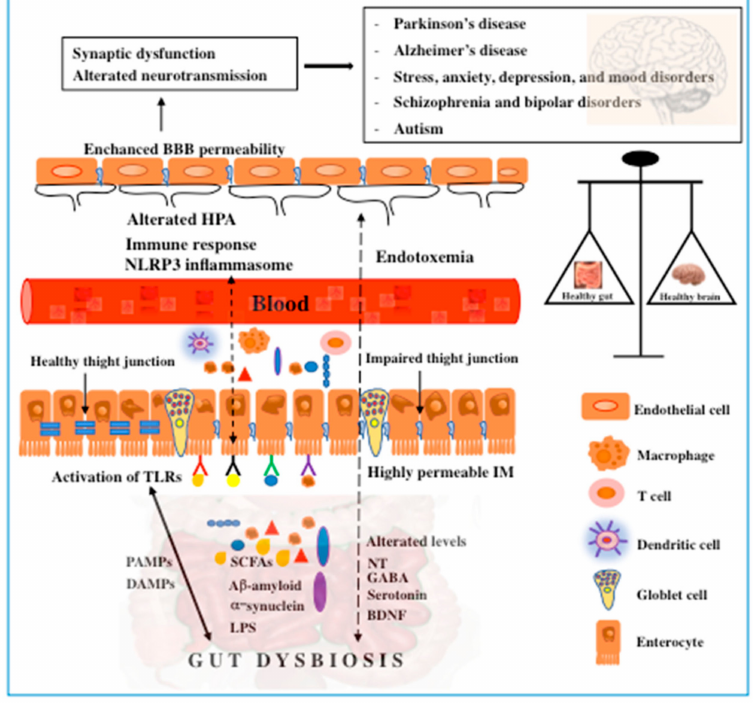
Figure 2. Schematic representation of the role of the gut microbiota in the pathogenesis of neurodegenerative and mental disorders and vice versa. A growing body of evidence suggests the bidirectional signaling between the gut microbiota and the brain in mediating brain diseases.